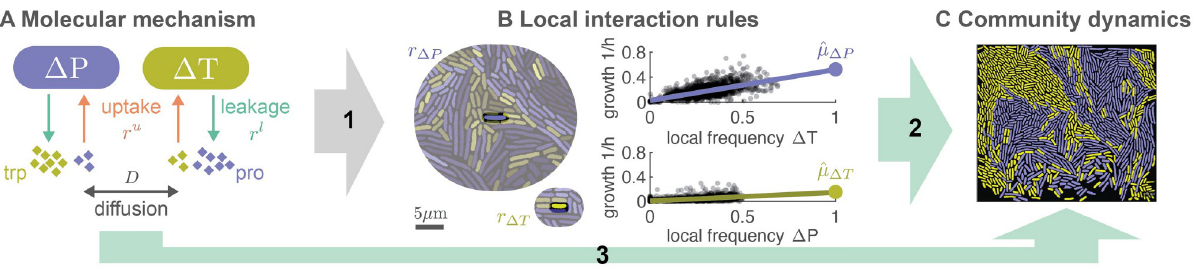
Fig 1. A mathematical framework to scale up from molecular-level properties, to individual-level properties, to community-level properties. We previously measured the local interaction rules for a cross-feeding community (B) and showed that these can be derived (arrow 1) from the molecular mechanisms of the interaction (A). Here we developed a mathematical model that derives community-level properties (C) either from measured local rules (arrow 2) or directly from the underlying molecular mechanisms (arrow 3). (A) The community consists of two types of Escherichia coli : Δ P is unable to produce the amino acid proline and Δ T is unable to produce the amino acid tryptophan. Cells exchange amino acids with the environment through active uptake (with rate r u ) and passive leakage (with rate r l ). Amino acids are exchanged between cells through diffusion in the environment (with rate D ). All rates differ between the two amino acids. (B) Local interaction rules can be fully described by two fundamental quantities: the size of the interaction neighborhood ( r Δ , r Δ , left); and the growth function of a cell (characterized by ^ m , right). Each dot corresponds to the measured growth T P rate of a single cell, n = 2610 for Δ P and n = 2162 for Δ T, the line shows the result of a linear regression, data reproduced from [11]. (C) We derive analytical expressions for steady state community-level properties, such as the equilibrium frequency of the two types, their spatial arrangement, and growth rate.